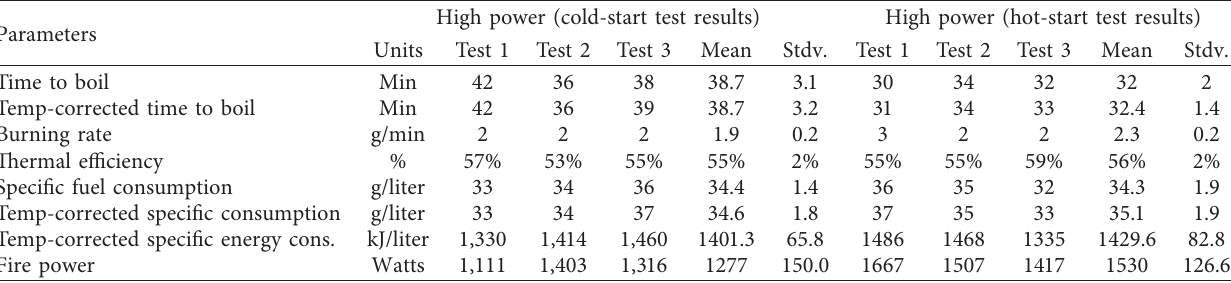
Table 7: Performance of the Jatrok stove using J20 fuel.